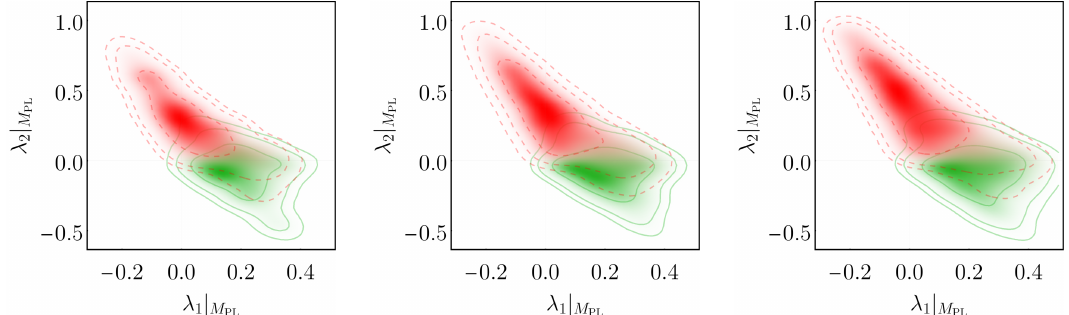
Figure 4 . Probability-density functions (PDFs) of the admissible (green) and non-admissible regions projected into the two-dimensional ( λ 1 σ -, 2 σ -, and 3 σ -regions obtained with a Gaußian kernel of width 0 . 05 . The different panels quantify the mild gauge-coupling dependence ( g | respectively) of the regions in theory